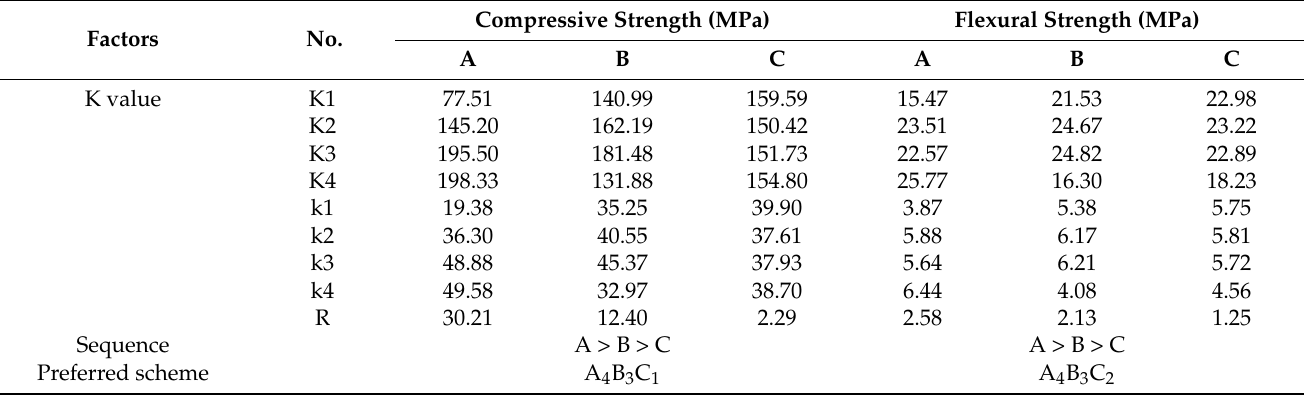
Table 5. Analysis results of the polar differences in the mechanical properties of the Na-based geopolymers at 7 days.